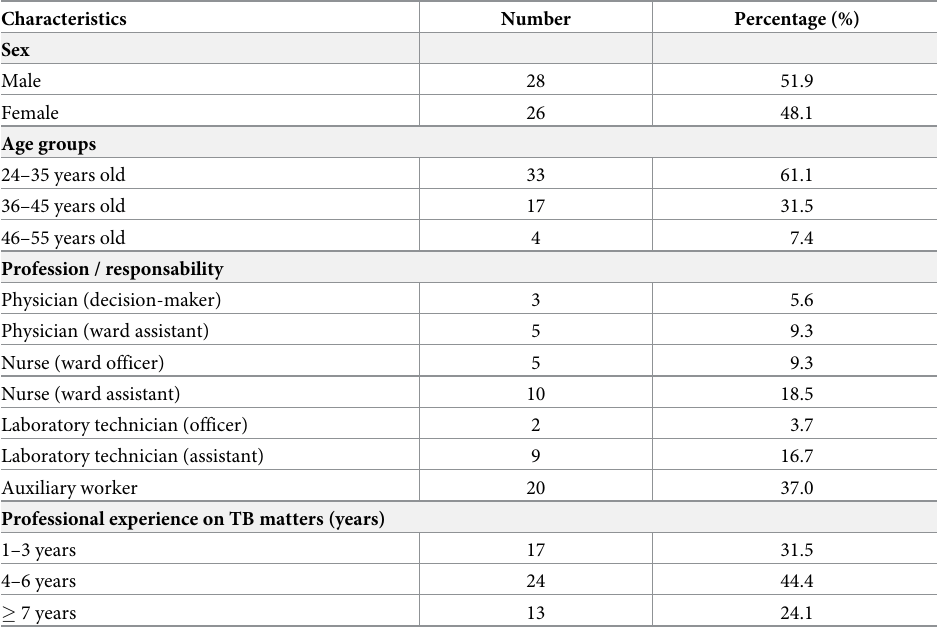
Table 1. Sociodemographic attributes of the respondents from Beira, Mozambique, 2019.